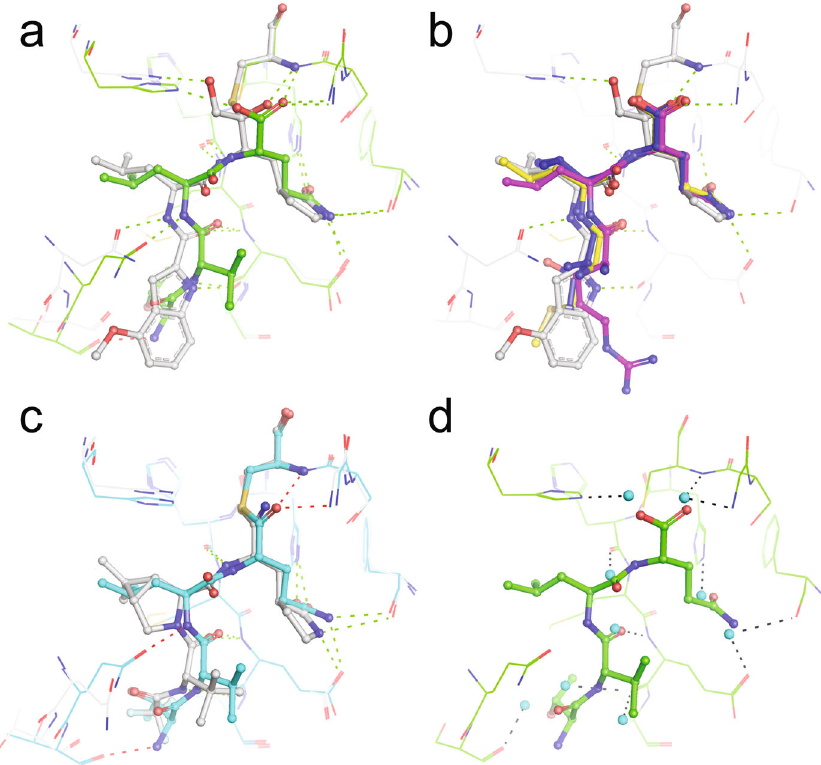
Fig. 7 | Clinical direct-acting antivirals (DAAs) mimic substrate binding to the SARS-CoV-2 M pro active site. a PF-00835231 (gray; PDB 6XHM 33 ) superposed with C12 product (green). Hydrogen bonds common to inhibitor and product colored green, hydrogen bonds unique to product red. b PF-00835231 (gray) superposed with C6 (form2)(blue),C10 (yellow) and C14 (magenta) products, whichadopt the kinked form2conformation. The productP3residue projectsacross the S3and S4